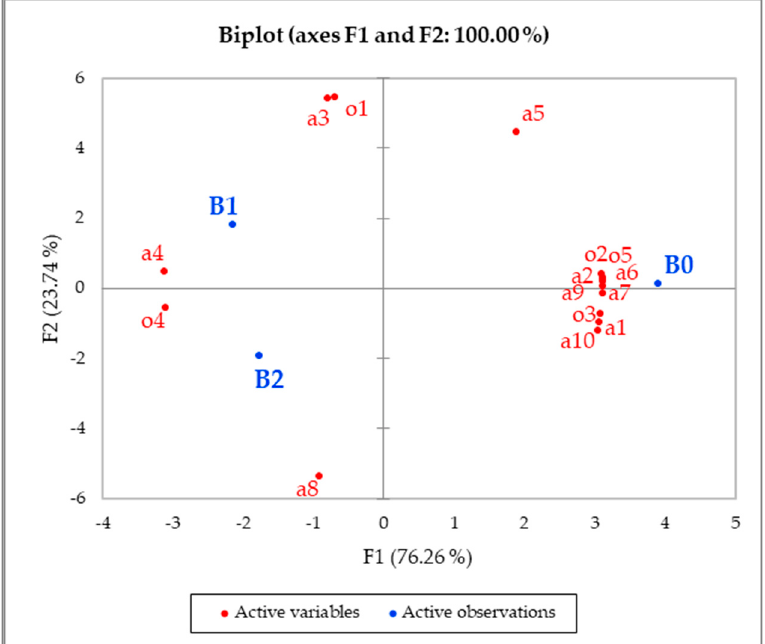
Figure 1. Principal component analysis of biscuit packages (B0, B1 and B2) showing correlations with sensory attributes (codes on plot refer to sensory attribute codes in Table 2).